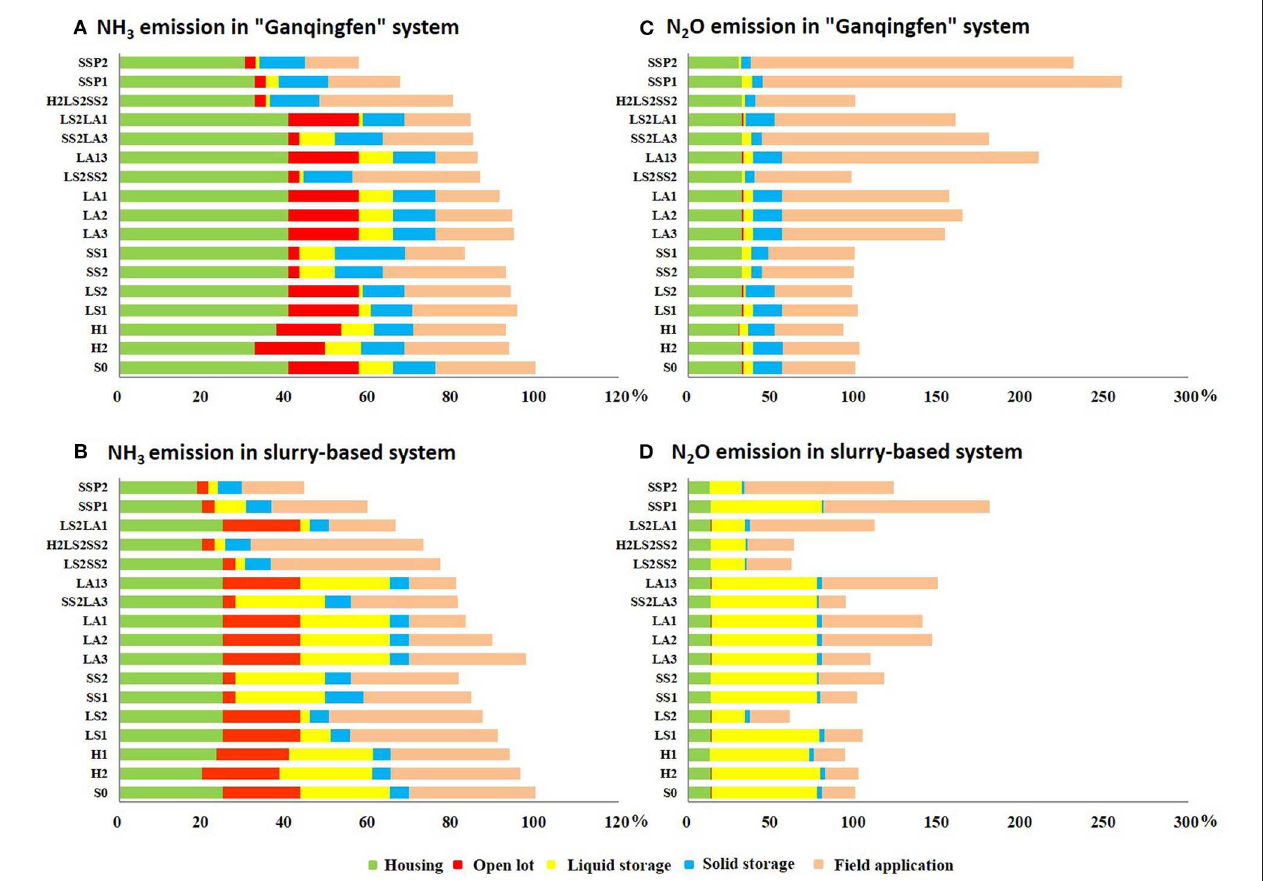
FIGURE 3 | Ammonia and nitrous oxide losses in manure management system under different scenarios. (A) NH 3 emission in “Ganqingfen” system. (B) NH 3 emission in slurry-based system. (C) N 2 O emission in “Ganqingfen” system. (D) N 2 O emission in slurry-based system.